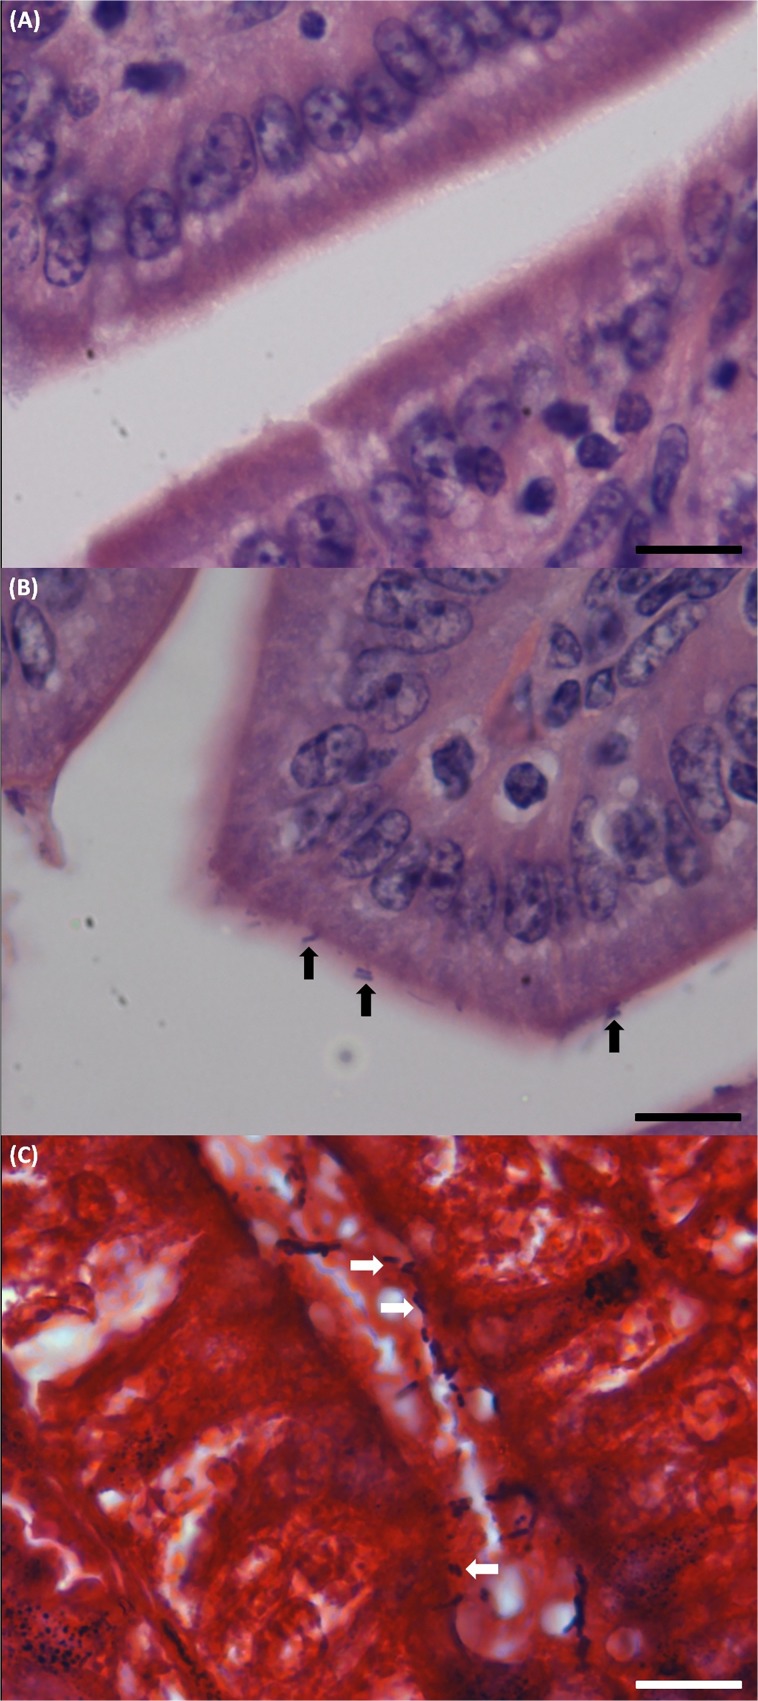
Histological analysis of sample sections of ileum of the C. perfringens challenged mice.Mice were intragastrically inoculated with the indicated strains and then sacrificed 48 h post-infection. (A) Hematoxylin and eosin staining of sample sections of ileum of the mice challenged with type A strain (Cp88), no C. perfringens compatible attached bacteria were observed. Scale bar, 20 μm. (B) In type E challenged mice many rod shaped bacteria compatible with C. perfringens (black arrows) were observed intimately attached to the intestinal mucosa. Scale bar, 20 μm. (C) Gram staining of a sample section of ileum of one of the type E challenged mice: Gram positive rod shaped bacteria compatible with C. perfringens attached to the gut mucosa (white arrows). Scale bar, 20 μm.